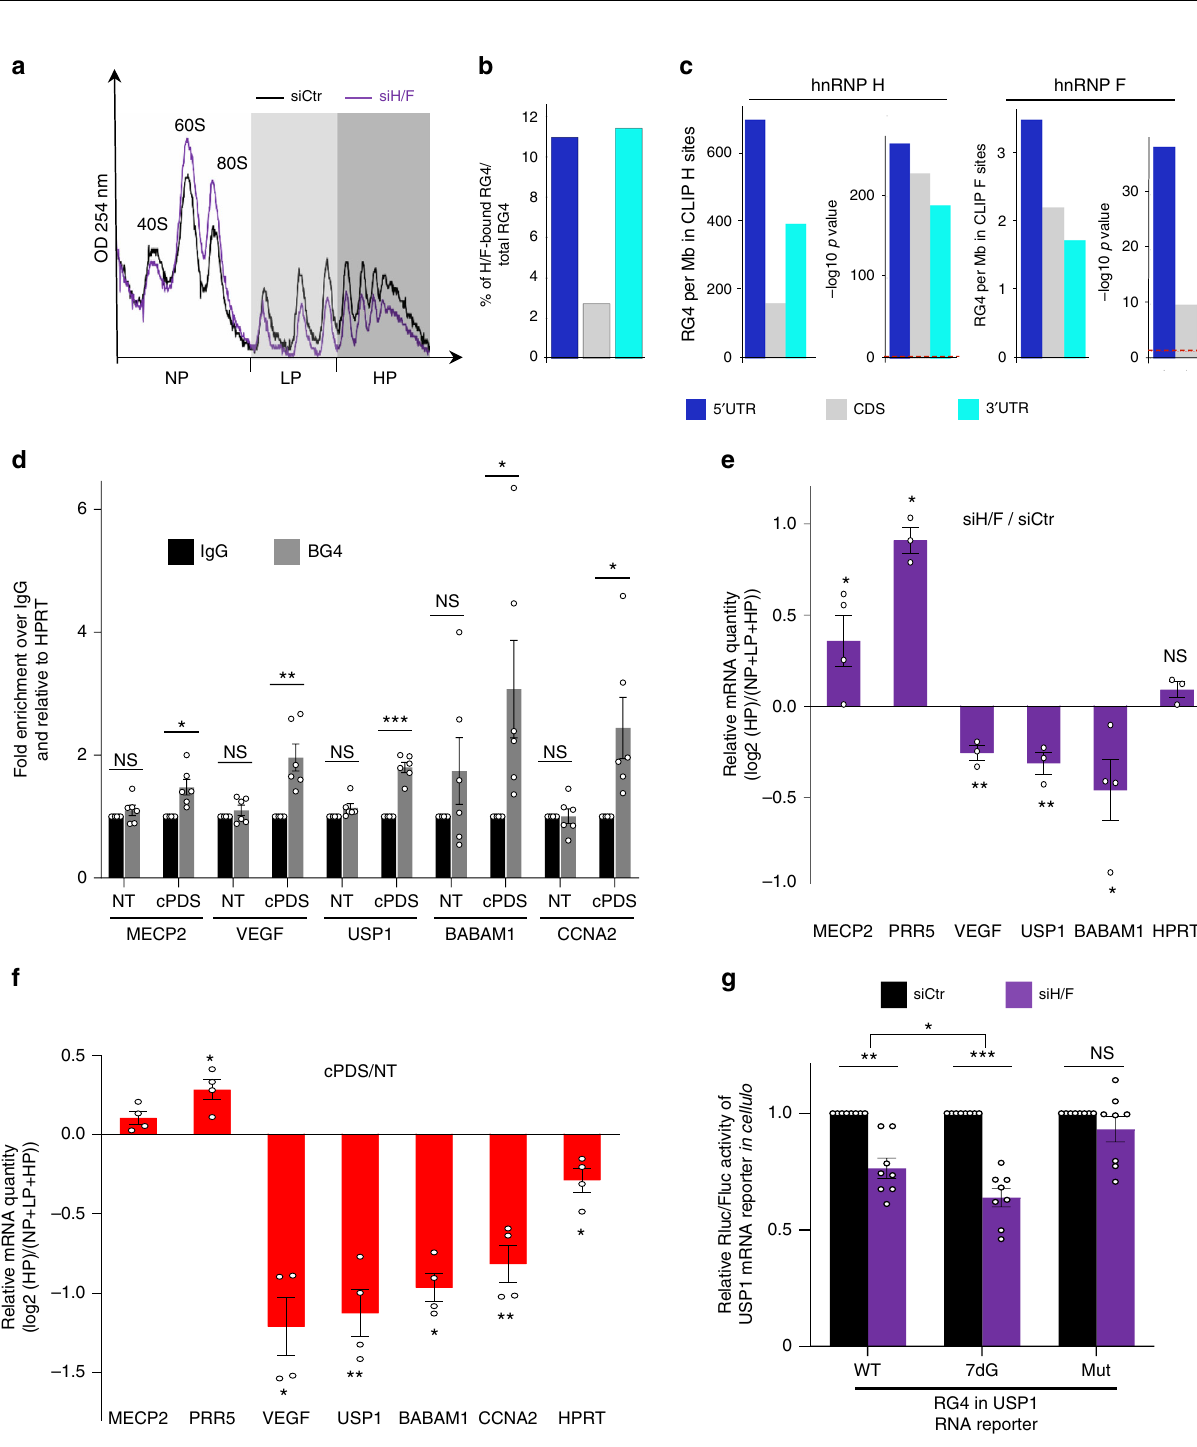
transcribed USP1 RNA reporters containing the RG4